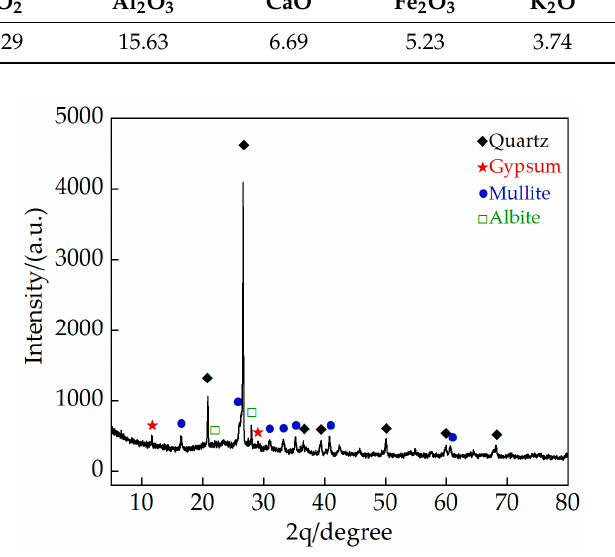
Figure 1. X-ray diffraction (XRD) patterns of original gray brick.